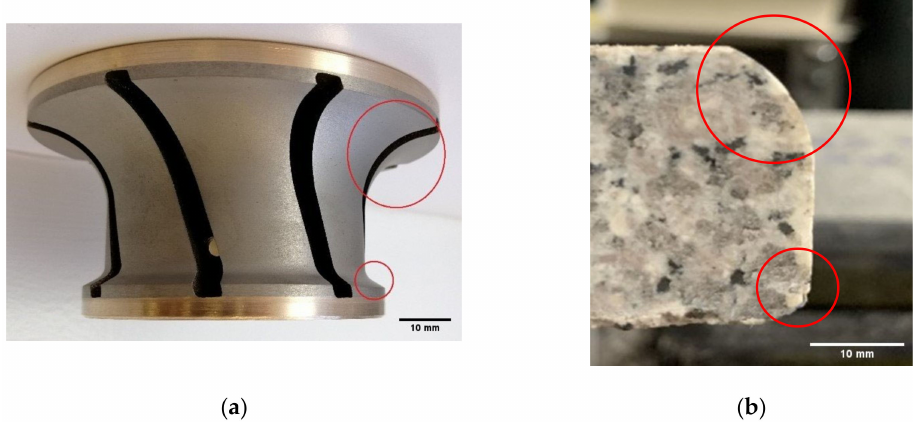
Figure 9. Illustration of the shapes produced with 600 grit tool: ( a ) shape on tool, ( b ) shape on granite